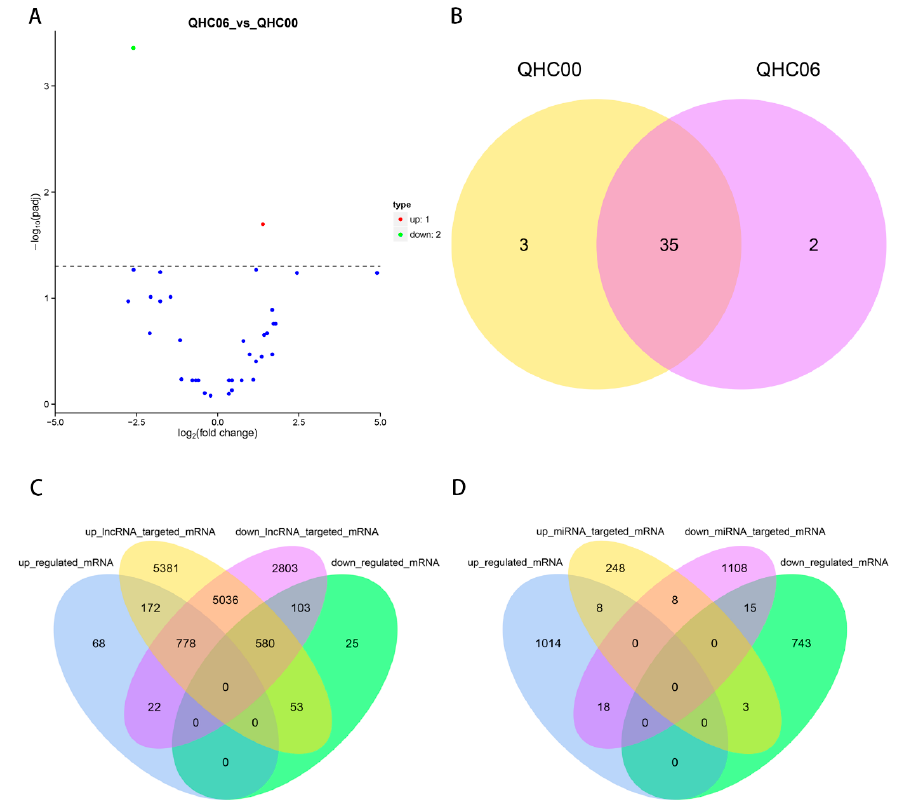
Figure 10. circRNA analysis and comprehensive analysis between QHC06 and QHC00. ( A ) Volcano plot of circRNAs in QHC06 vs. QHC00. Significantly di ff erentially expressed circRNAs are represented by red dots (up-regulated) and green dots (down-regulated), whereas non-di ff erentially expressed circRNAs are represented by blue dots. ( B ) Venn diagram of the numbers of expressed circRNAs between QHC06 and QHC00. ( C )Venn diagram of the intersection analysis between DE lncRNA targeted mRNA and DE mRNA. ( D ) Venn diagram of the intersection analysis between DE miRNA targeted mRNA and DE mRNA. Table 4. Information of DE lncRNA and its DE targeted Table 2. The detailed information of DE miRNAs.